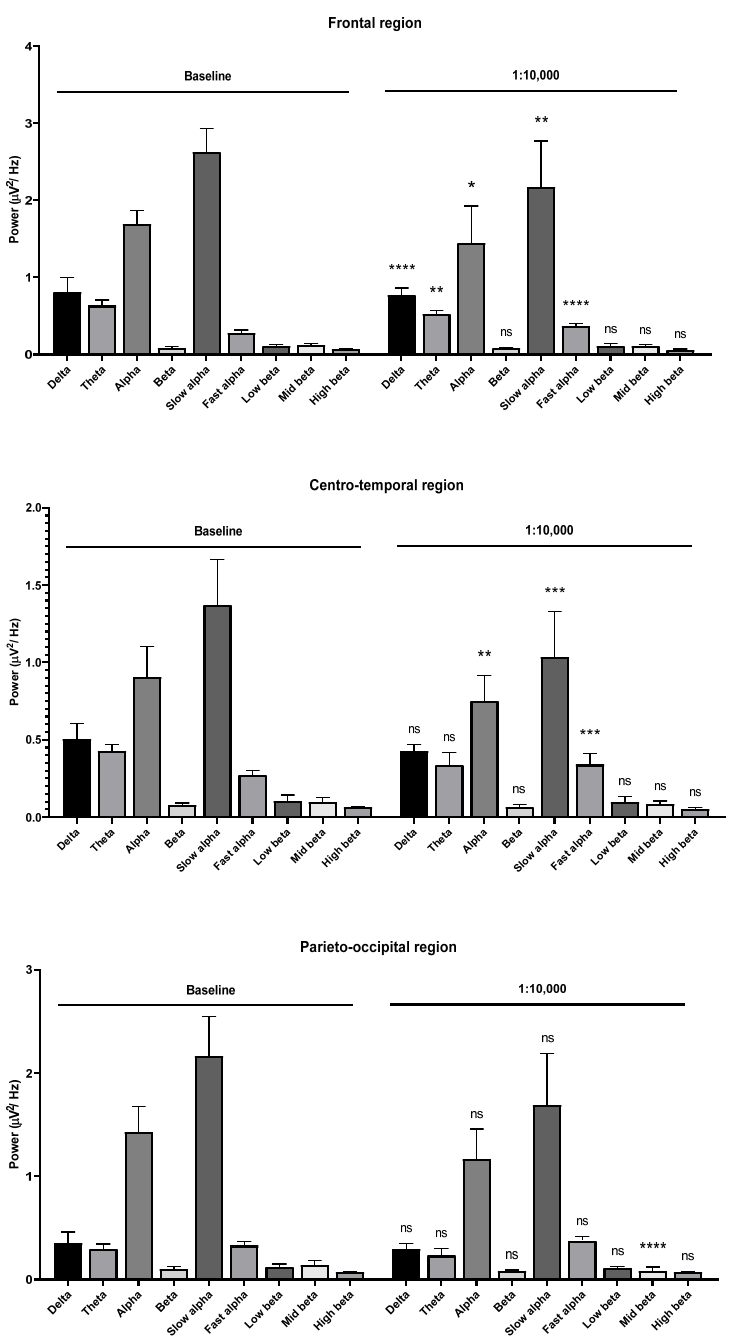
Figure 10. Effects of garlic oil inhalation at a 1:10,000 dilution on the delta, theta, alpha, beta, slow alpha, fast alpha, low beta, mid beta, and high beta wave powers: ( upper ) frontal region; ( middle ) centro-temporal region; ( lower ) parieto-occipital region. p value: not significant (ns) ≥ 0.05, * < 0.05, ** < 0.01, *** < 0.001, and **** < 0.0001.